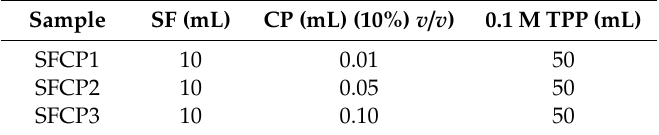
Table 3. Fibroin–carboplatin microparticles synthesis conditions for the ionic gelation method.